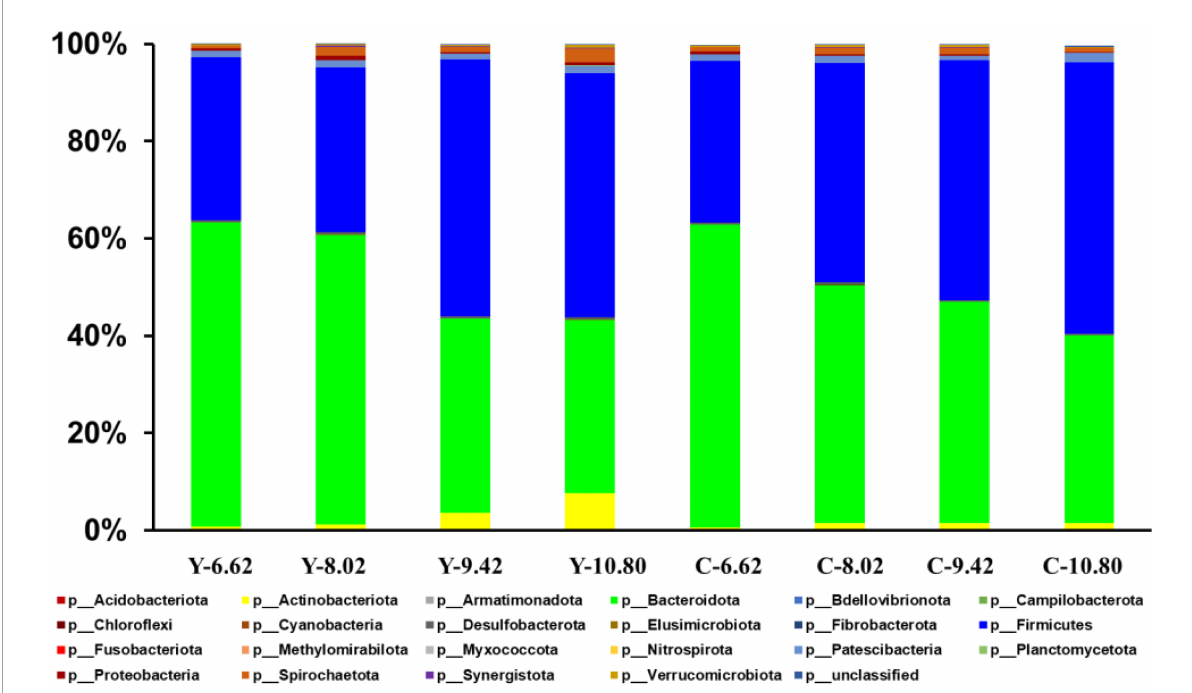
FIGURE3 Effects of dietary energy level (MJ ME/kg DM) on the yak (Y) and Qaidam cattle (C) rumen bacterial composition at the phylum level. Each bar and color represents the average relative abundance of each